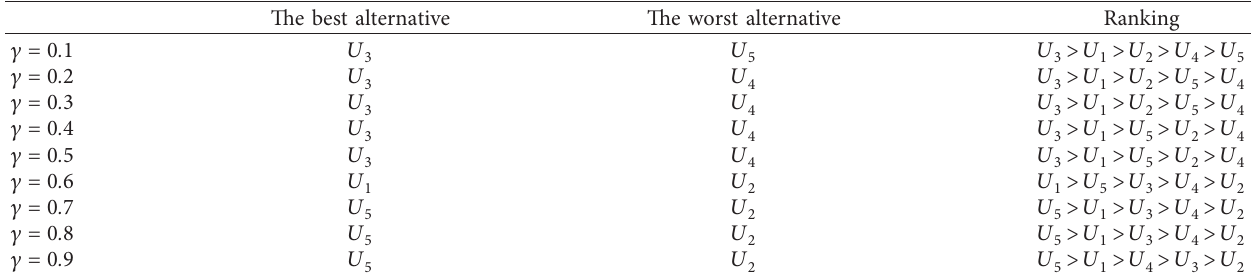
Table 15: The ranking results calculated by the VIKOR method with different parameter values of c . The best